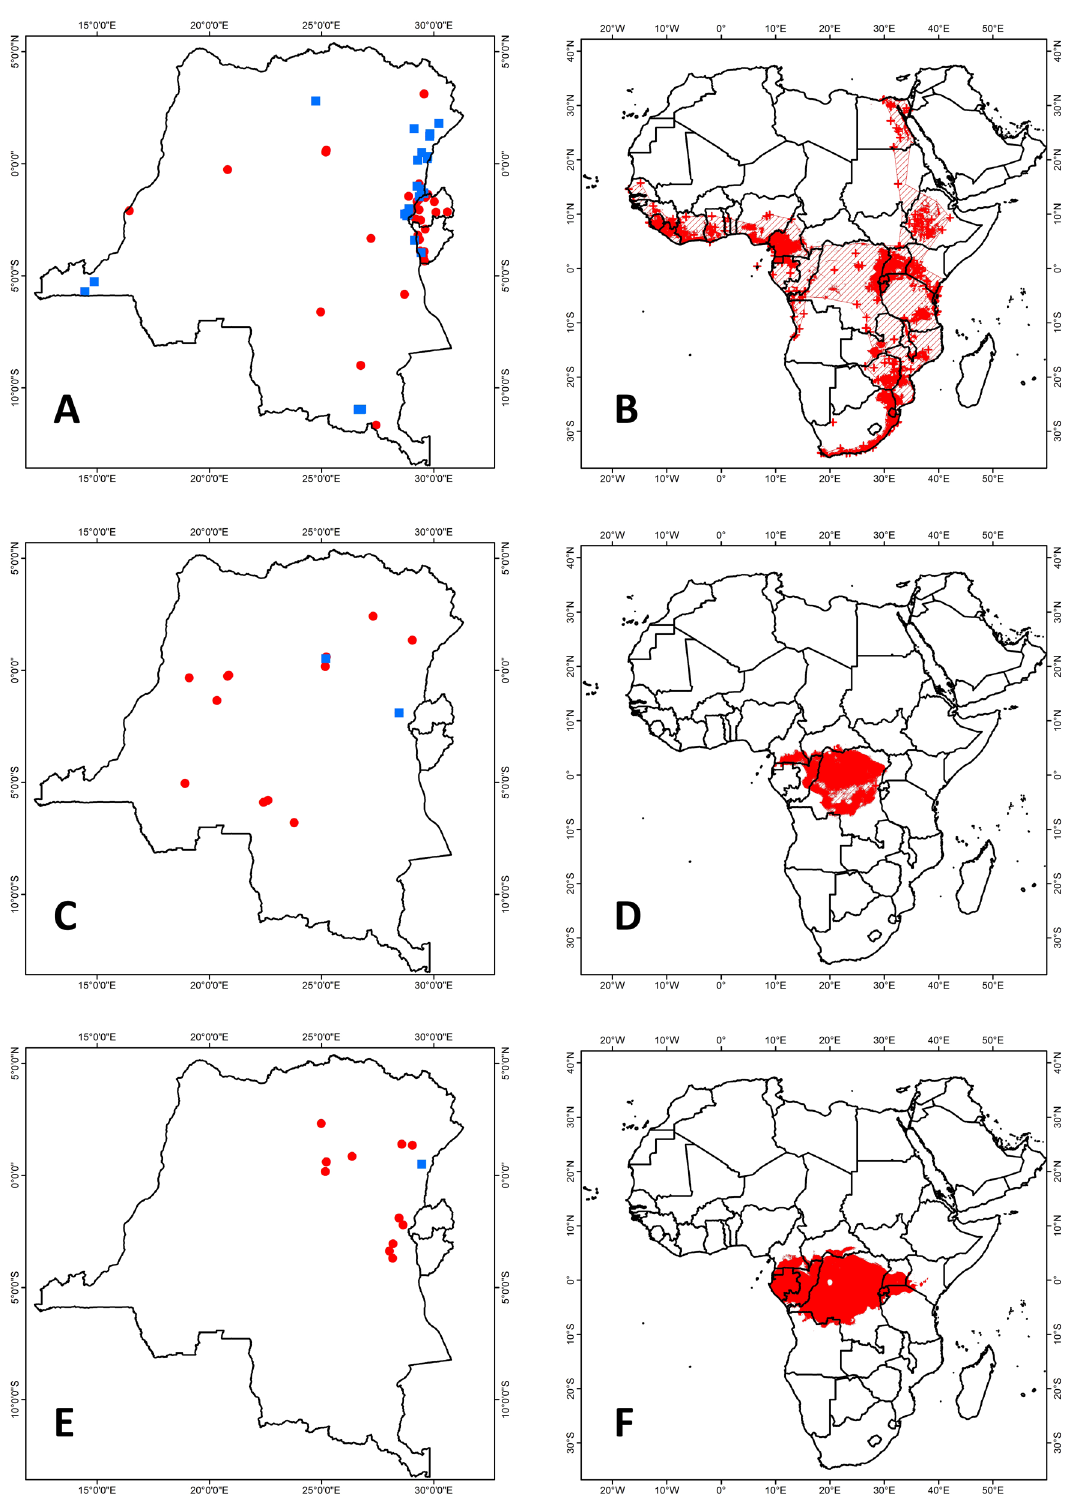
Fig. 9. Distribution maps. A–B . Rousettus aegyptiacus (E. Geoffroy St.-Hilaire, 1810). C–D . Casinycteris argynnis Thomas, 1910. E–F . Scotonycteris bergmansi Hassanin et al ., 2015. A, C, E. Distribution in